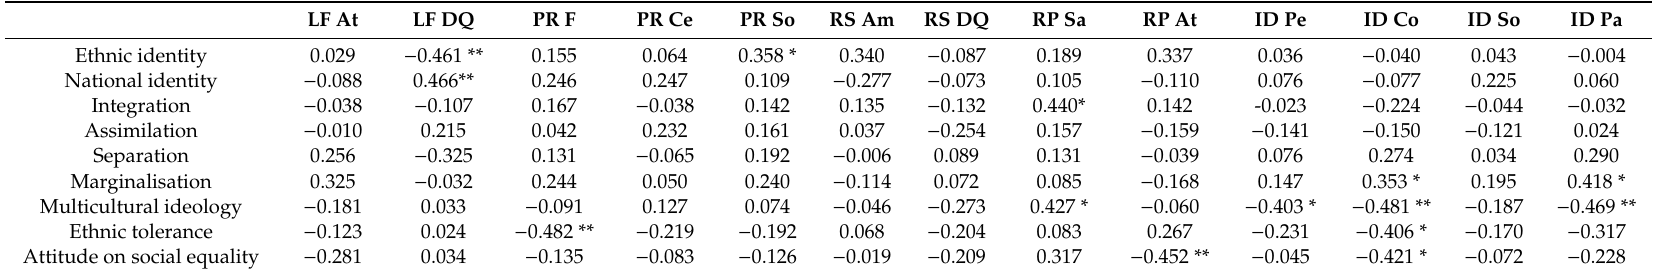
Table 5. The association of acculturation with behaviours of domains of CIYCFP ( n =